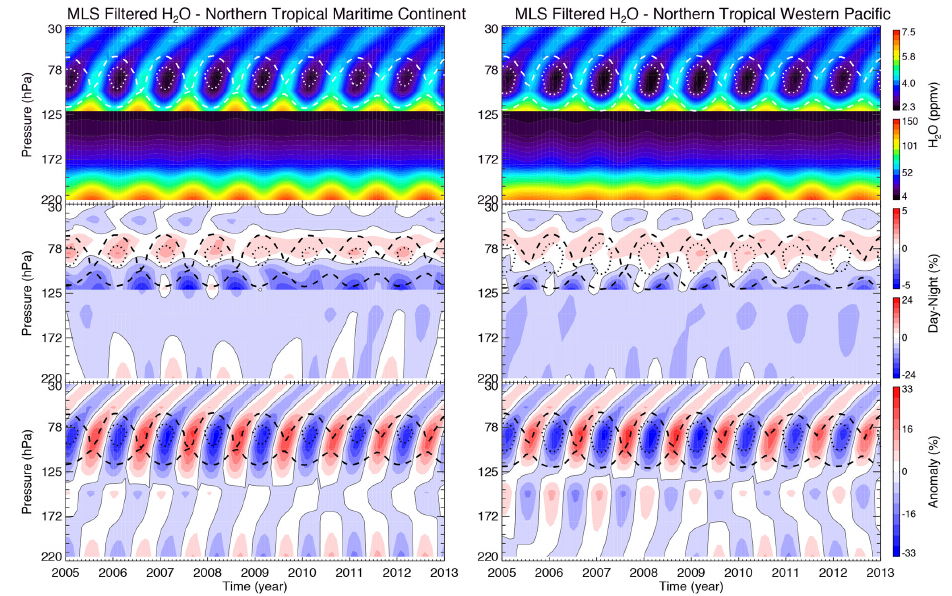
Figure 7b. Same as Fig. 6a but for the northern tropical maritime continent (left) and the northern tropical western Pacific (right).